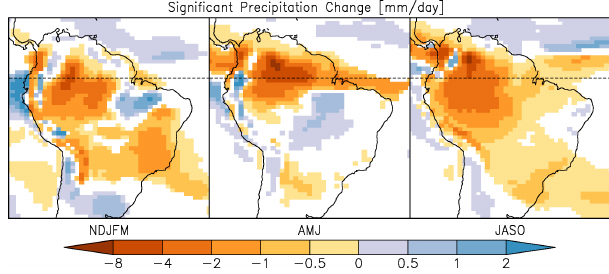
Figure 5. Change in precipitation (mmday − 1 ) for NDJFM, AMJ and JASO. Shading indicates significance at the 95% confidence level.